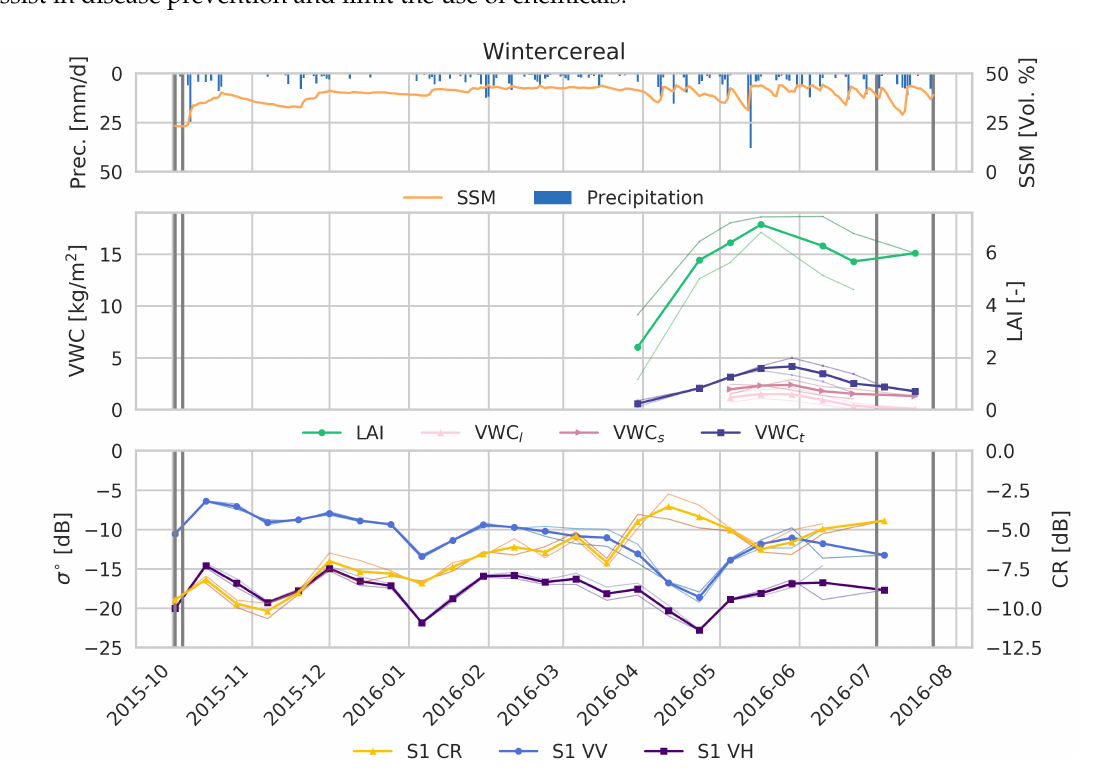
Figure 6. Time series of Sentinel-1 and in situ variables as in Figure 2 for winter cereal